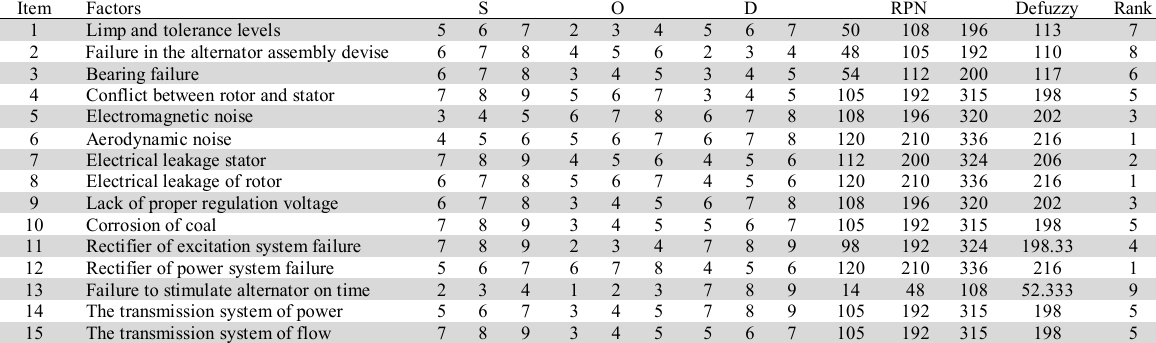
The summary of factors associated with alternator failure along with fuzzy